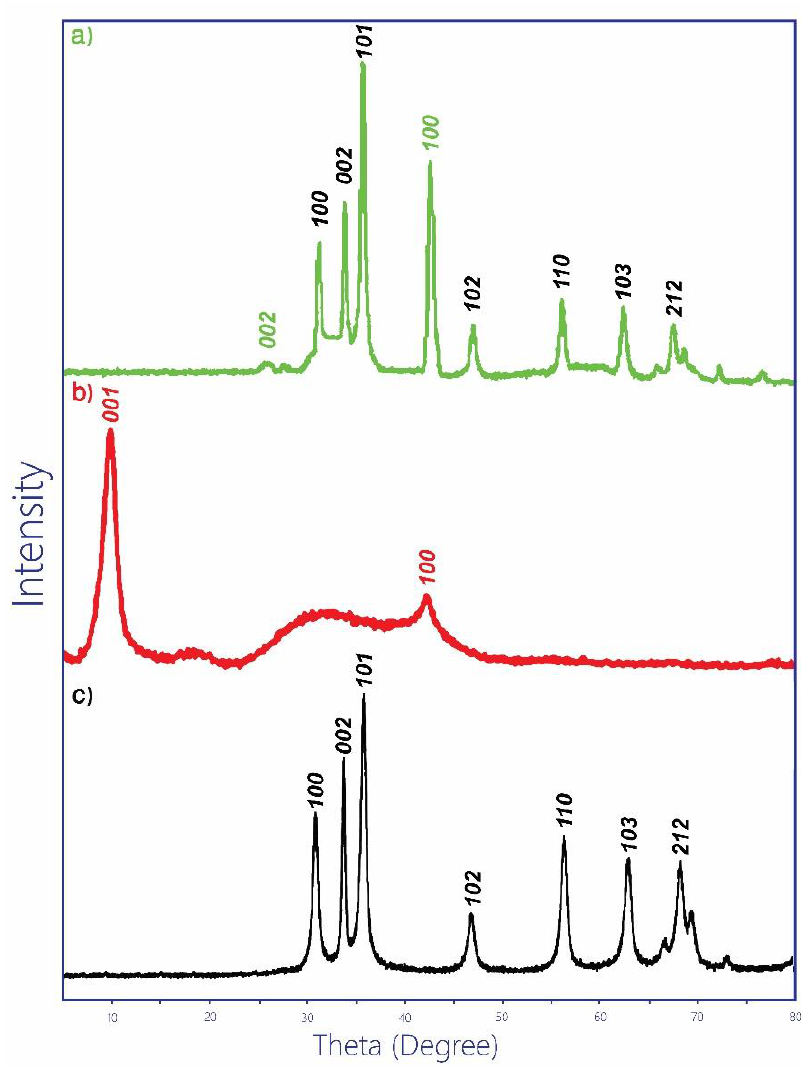
Figure 3. XRD pattern of ( a ) ZnO-MWCNT, ( b ) GO-NPs, and ( c ) ZnO.